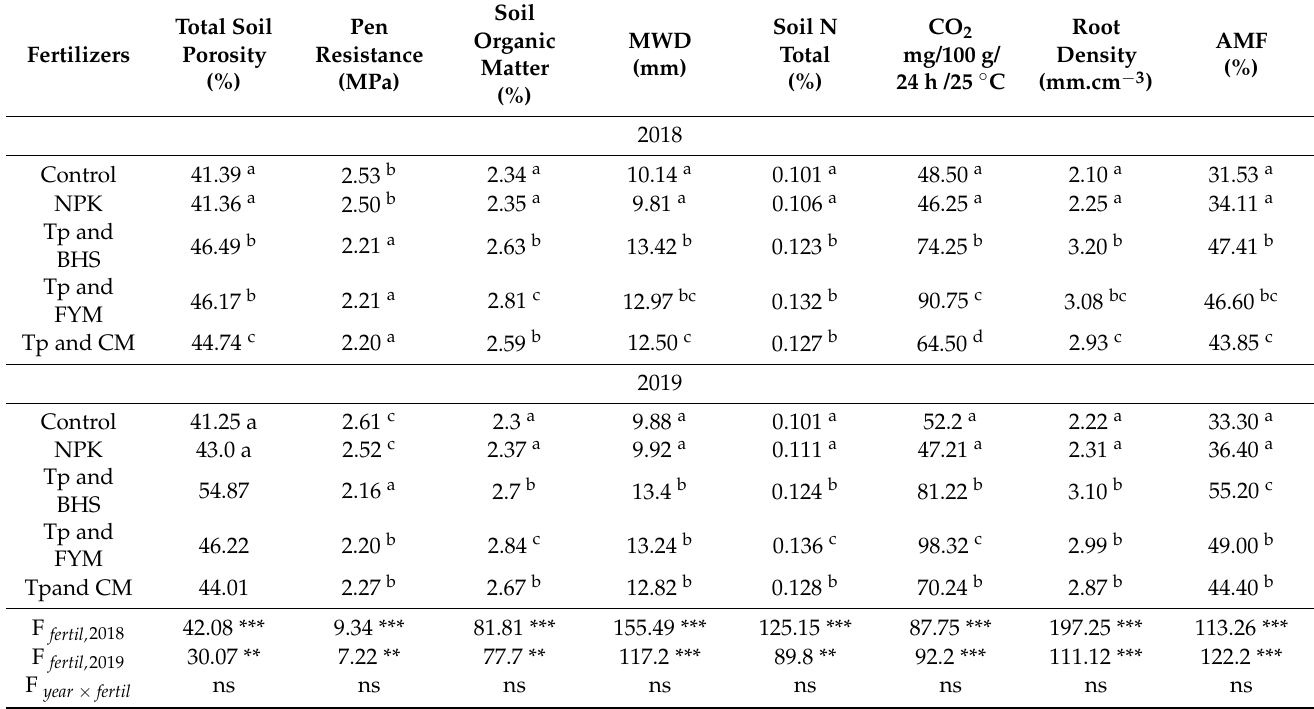
Table 2. Soil characteristics as effected by fertilizer treatments (control, NPK, Tp and BHS, Tp and FYM, and Tp and CM). Total Fertilizers